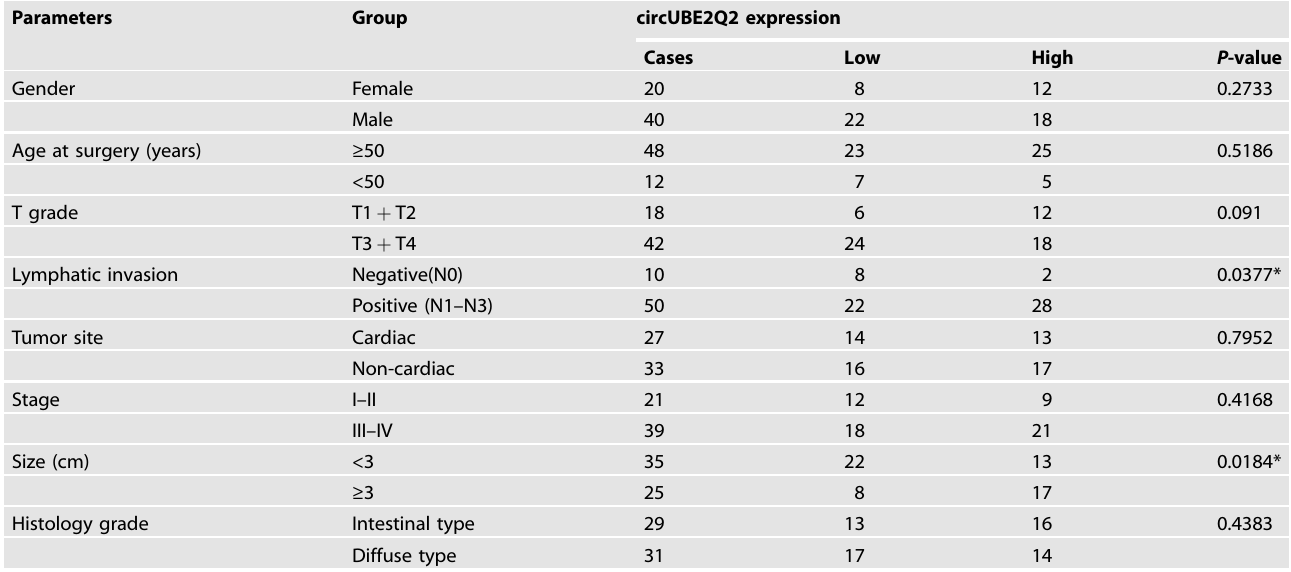
Table 1. Clinicopathological features of 60 gastric cancer patients and the expression of circUBE2Q2.